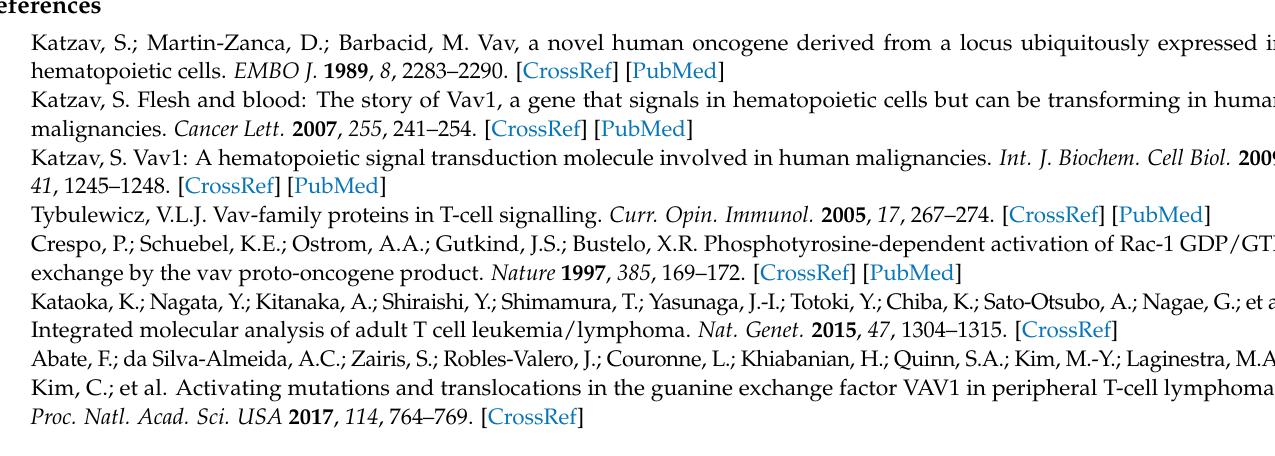
Figure S2: Analysis of spleens from RosaVav1 mice; Figure S3: Presence of T cells in the Lymphomas of Rosa Vav1 mice; Figure S4: Vav1 activity as GEF for Rac in liver tissue from Rosa Vav1 mice; Table S1: Primers used in this study; Table S2; List of antibodies used in this